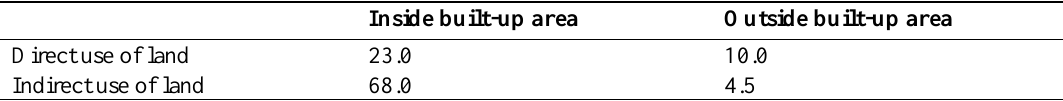
Table 6. Financial valuation of land (in Euro per m 2 ) Inside built-up